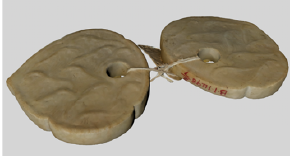
Figure 28 . The jade pendant model from Hailongtun.